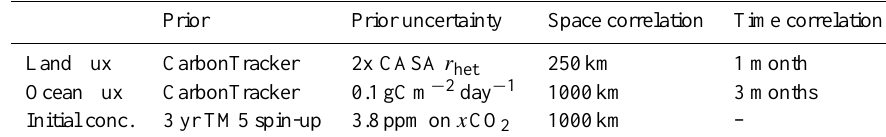
Table 3. Boundary and initial conditions specified to all models.